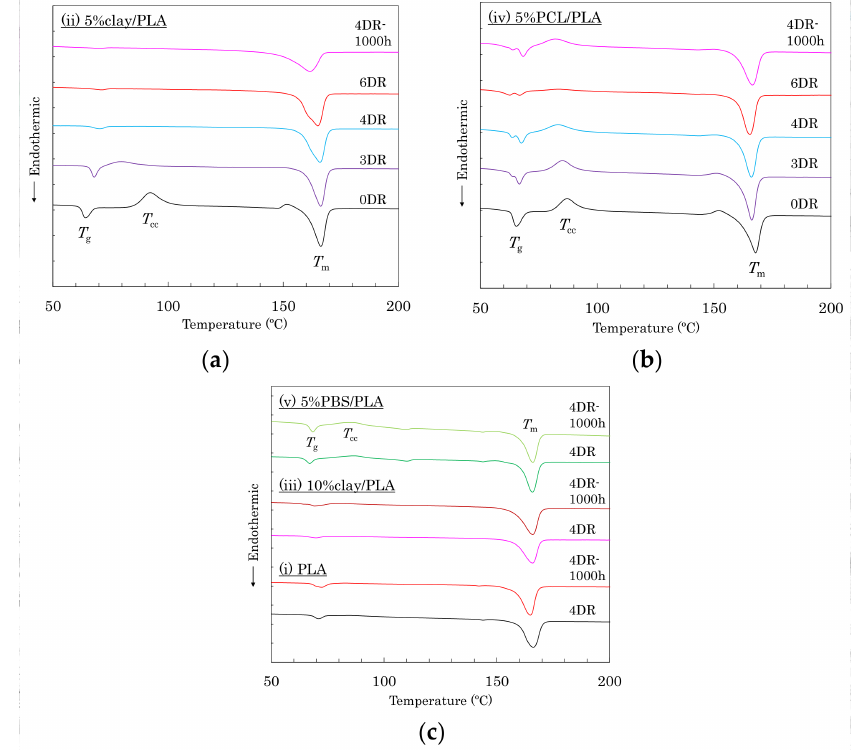
Figure 2. DSC heating curves: ( a ) (ii) 5% clay/PLA; ( b ) (iv) 5% PCL/PLA; ( c ) 4 DR and 1000 h degraded (i) PLA, (iii) 10% clay/PLA, and (v) 5%